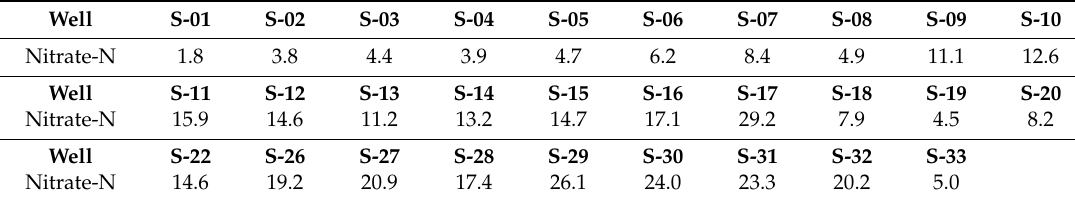
Figure 2. The distribution of the concentration of ( a ) nitrate-N and ( b ) acesulfame. Table 7. The concentrations of nitrate-N (unit: mg/L).